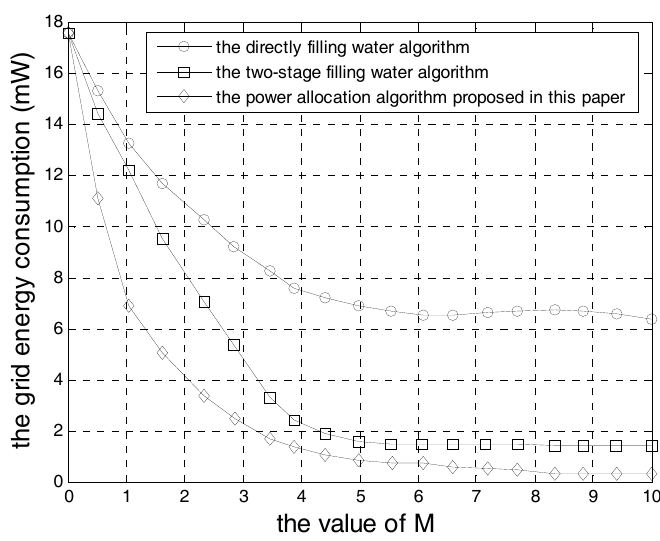
Figure 6. The grid power consumption with different power allocation algorithm. α i = α ∗